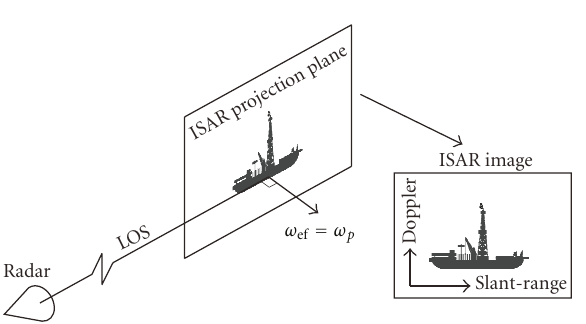
Figure 2: A scenario example to show the ISAR projection plane.